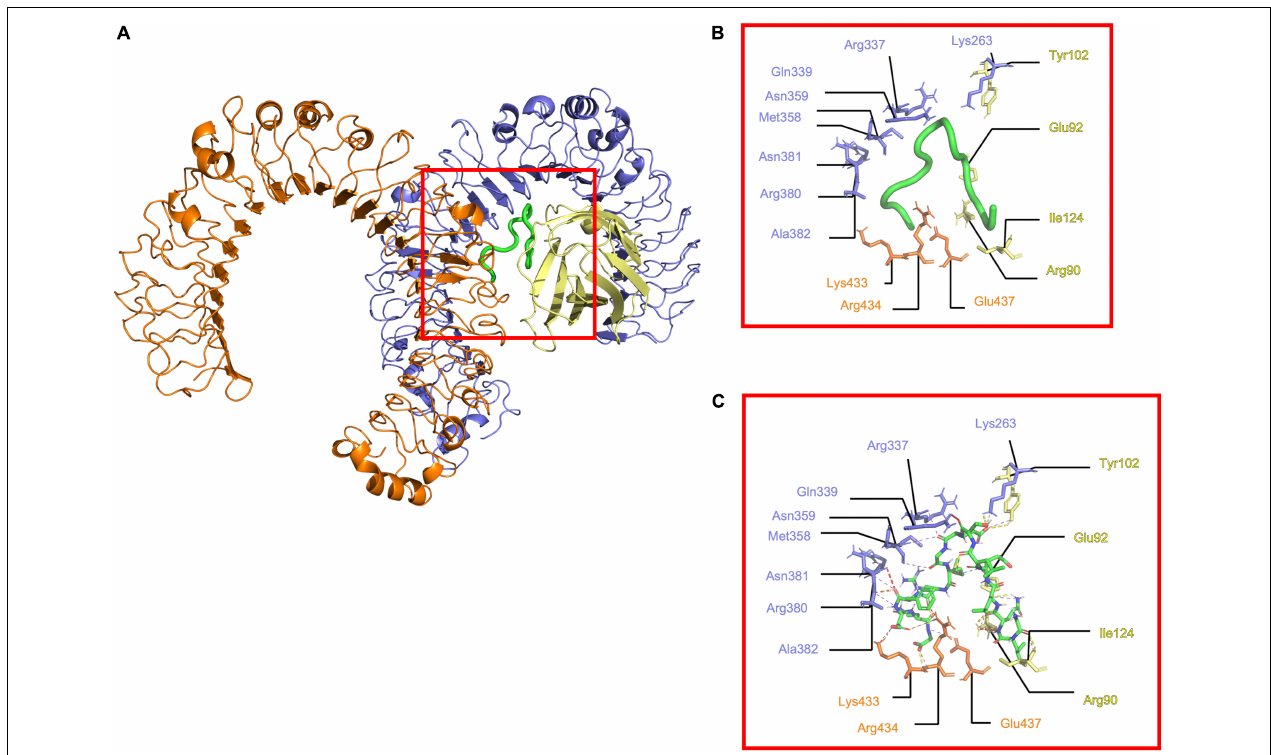
FIGURE 2 | Determined interactions between Peptide-2 and (mTLR4/MD2) 2 . (A) General view of Peptide-2 (red square) docked into (mTLR4/MD2) 2 (TLR4 is shown in purple, MD2 in yellow, and TLR4* in orange). (B) Detailed residues interacting with Peptide-2 colored in a segment belonging manner. (C) Detailed interactions occurring between residues and Peptide-2 (showed in a licorice representation with carbon atoms in green, oxygen atoms in red, hydrogen atoms in white, and nitrogen atoms in blue), hydrogen bonds are shown as a yellow dashed line, electronic clashes in a red dashed line, and electrostatic interactions in a magenta dashed line. All images were obtained with PyMOL and interactions identified with the ShowContacts